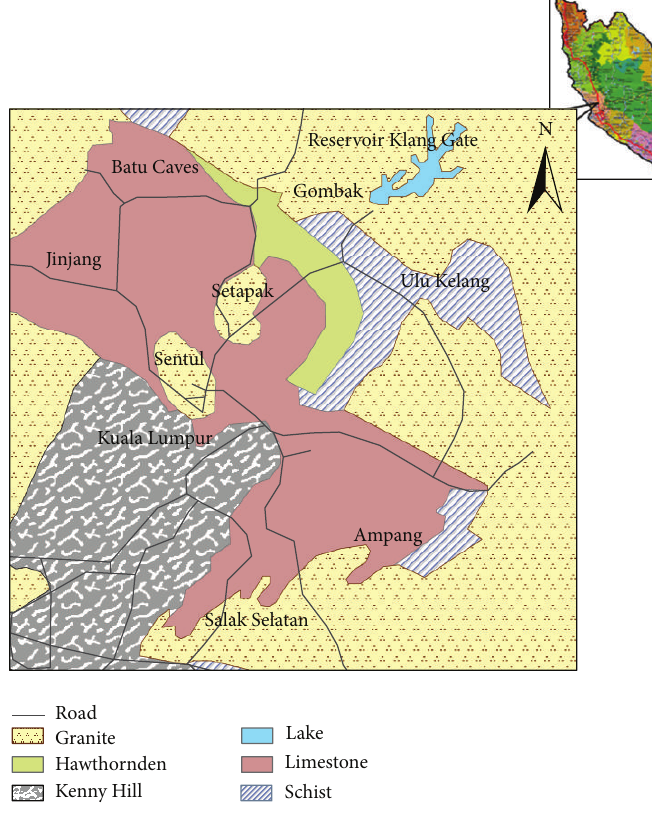
Figure 1: Geological map of the study area [15].